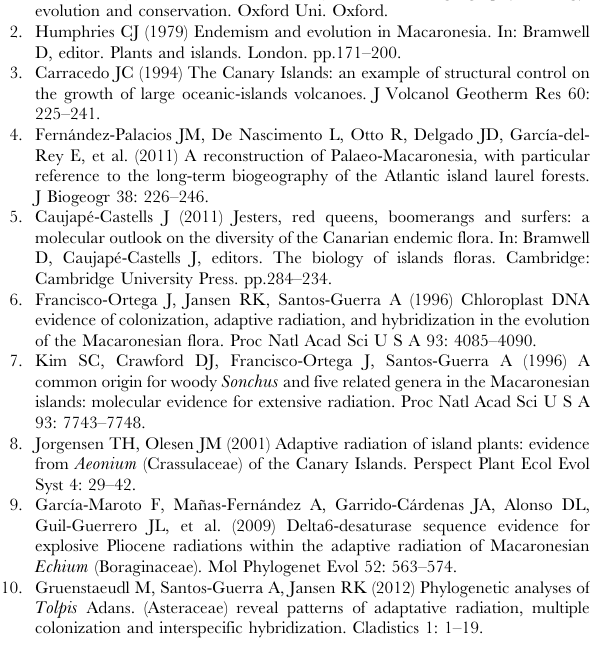
Table S4 Pair-wise F ST distances based on AFLP data calculated among the Macaronesian Cheirolophus pop- ulations included in this